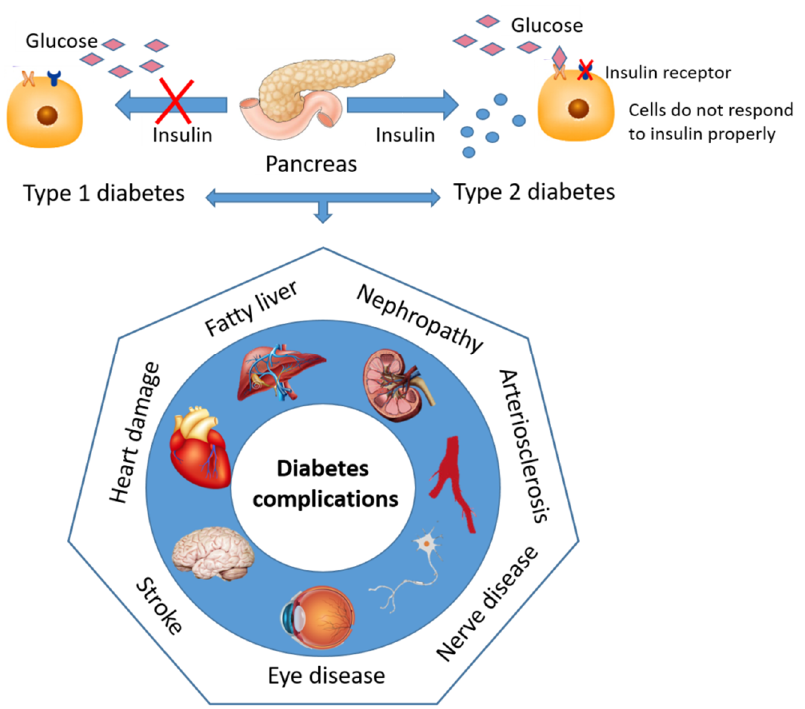
Figure 1. Major microvascular and macrovascular complications associated with diabetes